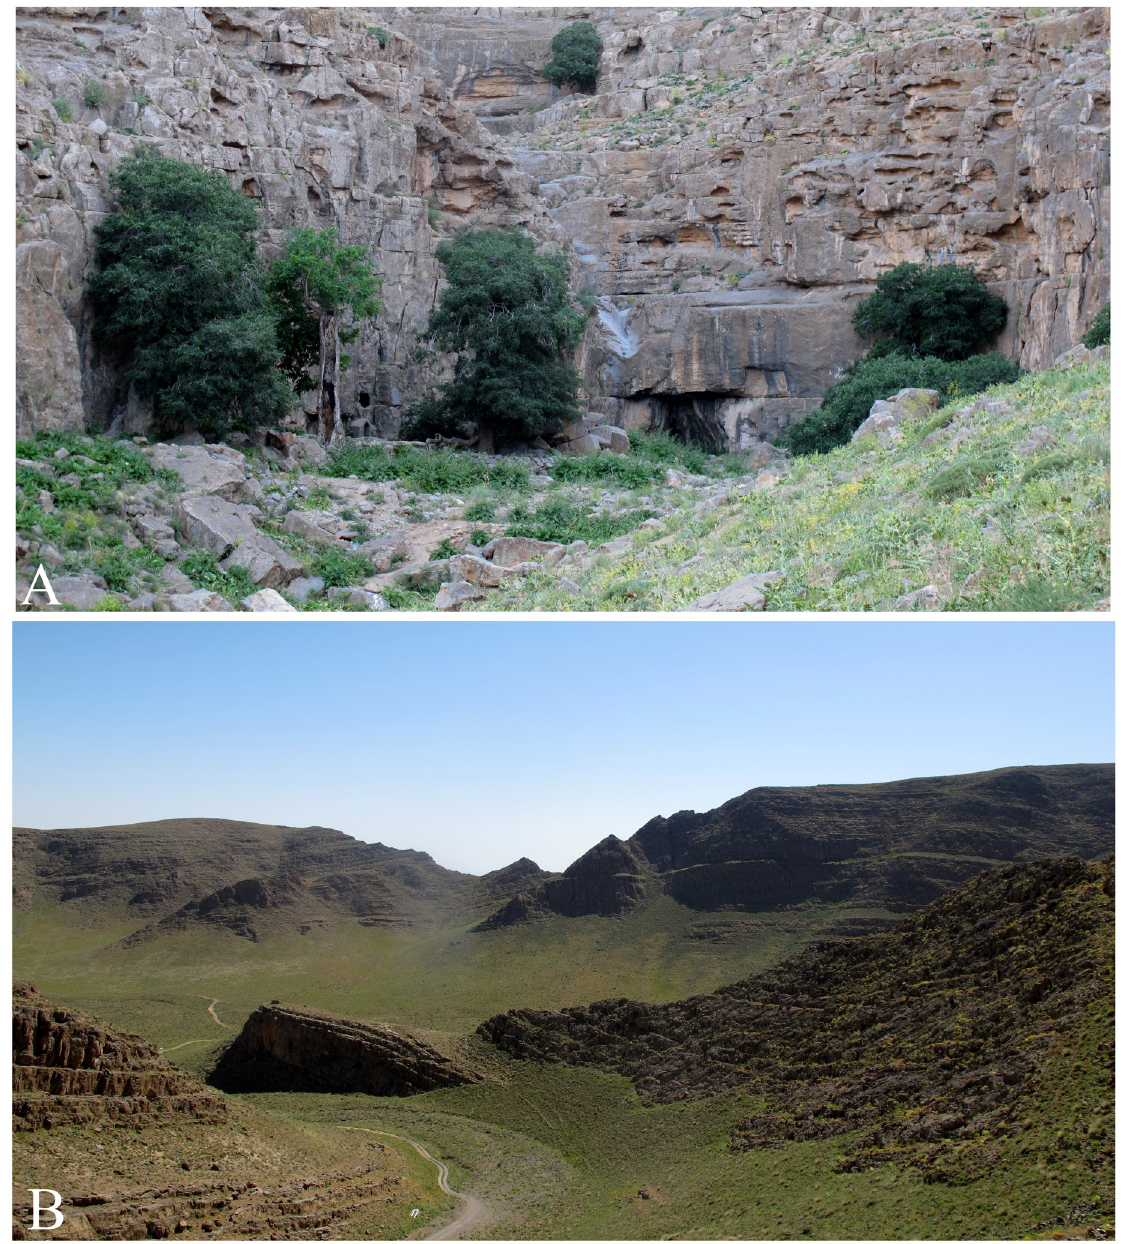
Fig. 1. A–B . Chekab Valley, Haftad Qolleh Protected Area, Markazi province,